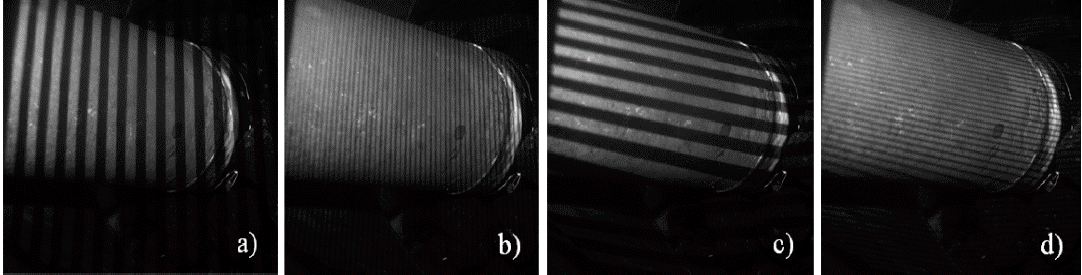
Figure 10. Selected images from fringe sequence: parts of Gray-code sequence ( a , c ) and sinusoidal fringes ( b , d ) taken from underwater measurements of a pipe.